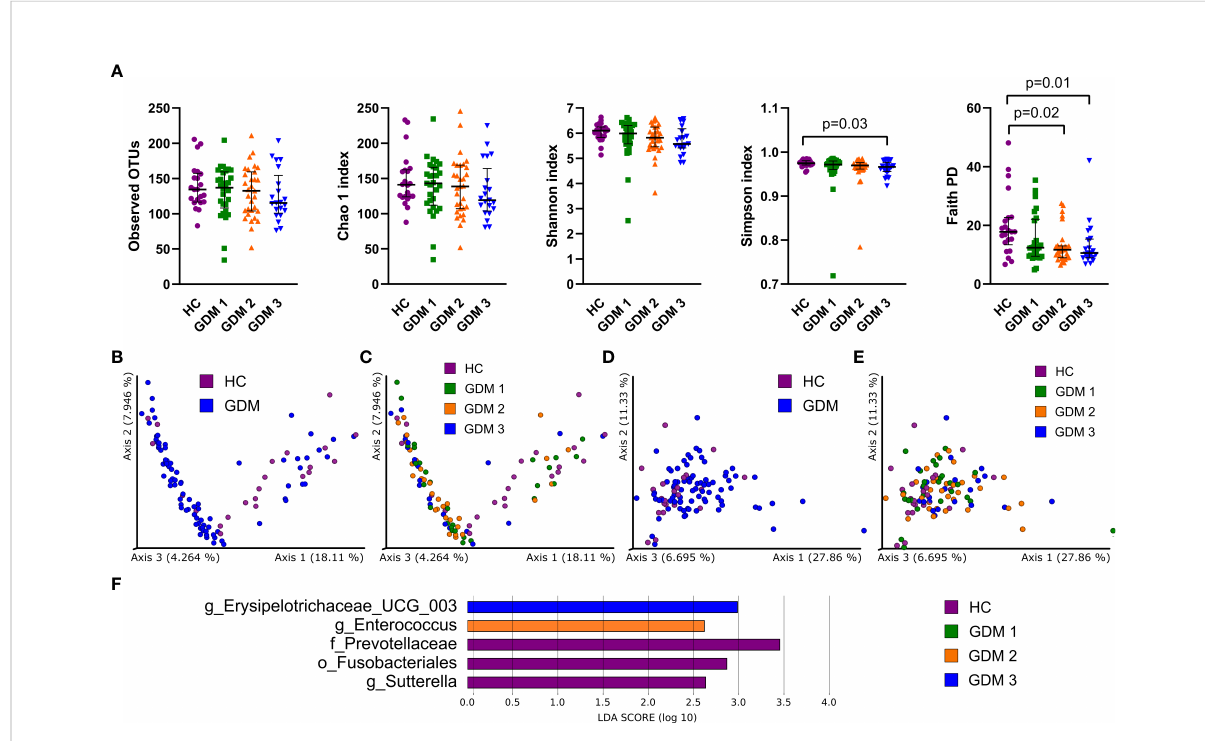
FIGURE 1 Gut bacterial community composition in the fi rst trimester of pregnancy. (A) Alpha diversity indexes. Beta diversity of gut bacteria on unweighted (B, C) and weighted (D, E) UniFrac distance metric-based PCoA graphs show comparison of control healthy pregnant women (HC) with those with gestational diabetes mellitus (GDM) diagnosed at any time during the pregnancy. (F) LEfSe analysis of signi fi cantly different strains among groups. Statistically signi fi cant differences were measured by Kruskal-Wallis test with Dunn´s post-hoc testing. The data are presented as medians with interquartile range. OTUs, operational taxonomic units; PD, phylogenetic